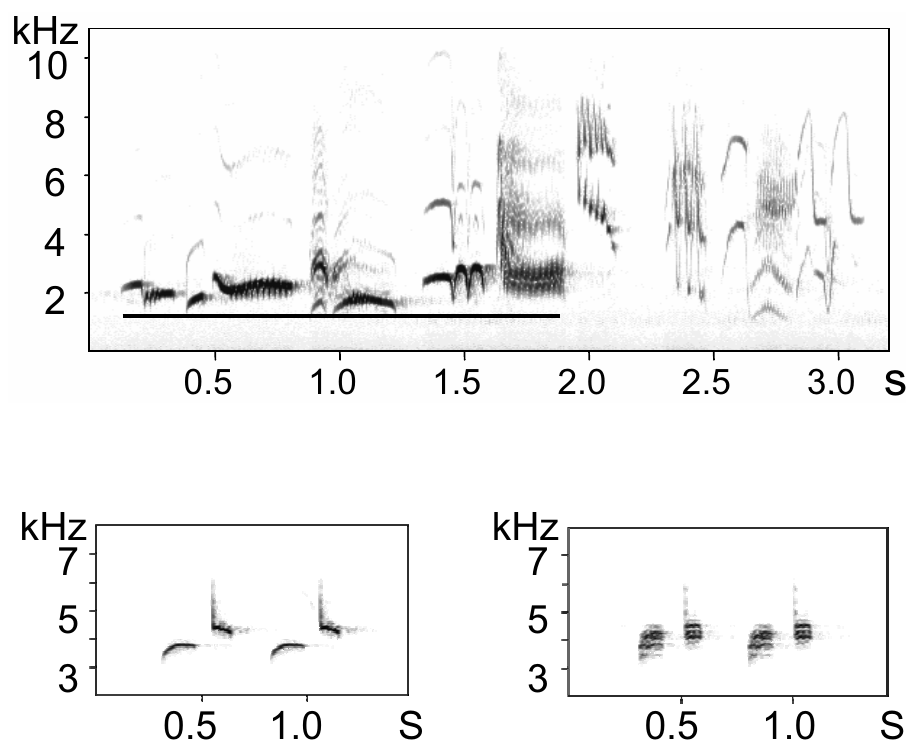
Fig. 1 – Predictions for public signaling. Sound transmission experiments predict that public signaling should include the use of high SPL, low frequency, narrowband and unmodulated signals, emitted above the ground level, possibly from high perches. In Blackbirds Turdus merula (above), whistle sounds (underlined) transmit better than twitter sounds. In Great Tits Parus major (below), pure notes (left) transmit better than buzzes (right).